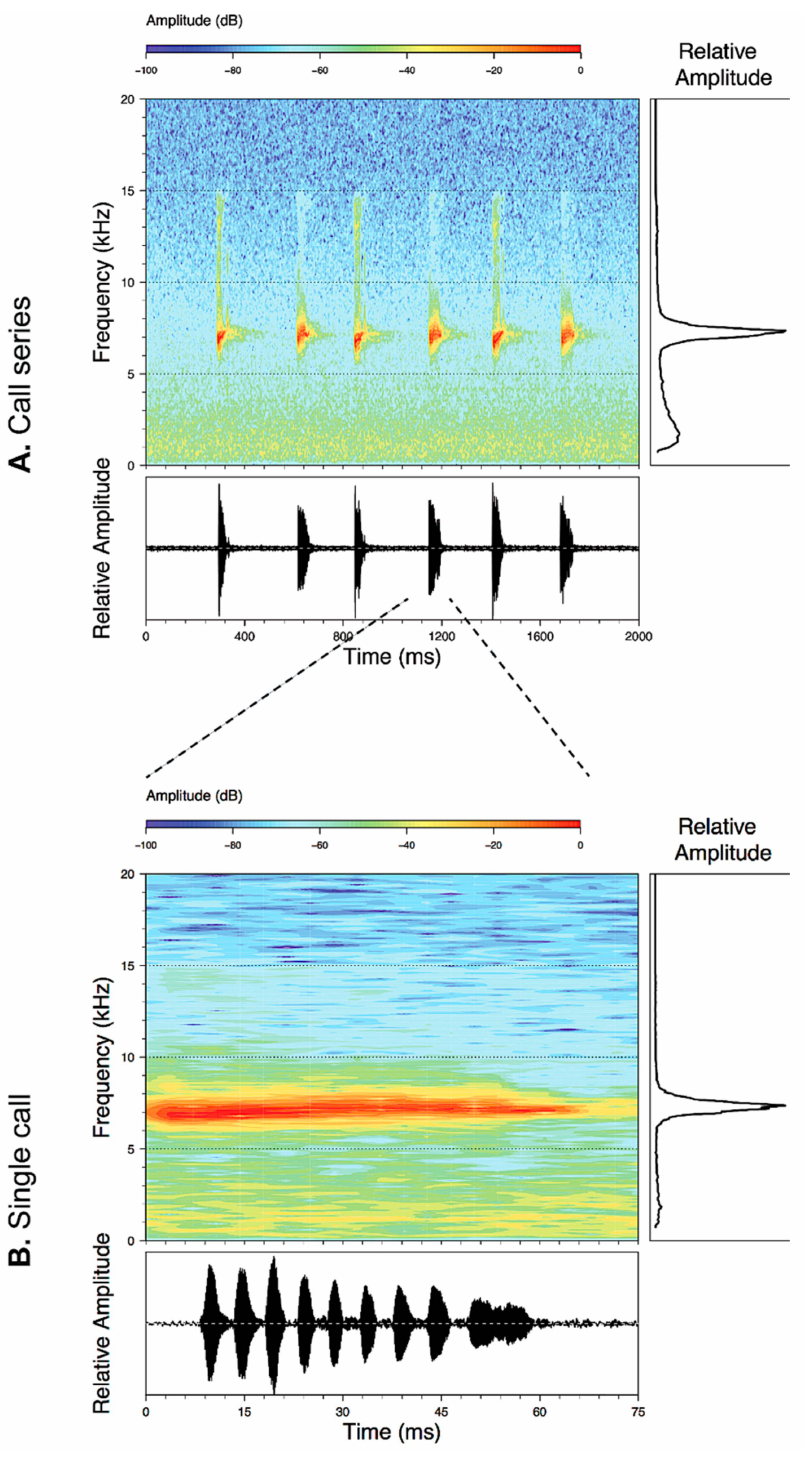
Figure 52. Call of Centrolene peristicta (LBE-C-047), recorded at Reserva Las Gralarias, 1800 m, Pichincha province, Ecuador. ( A ) Series of calls. ( B ) Single, pulsed